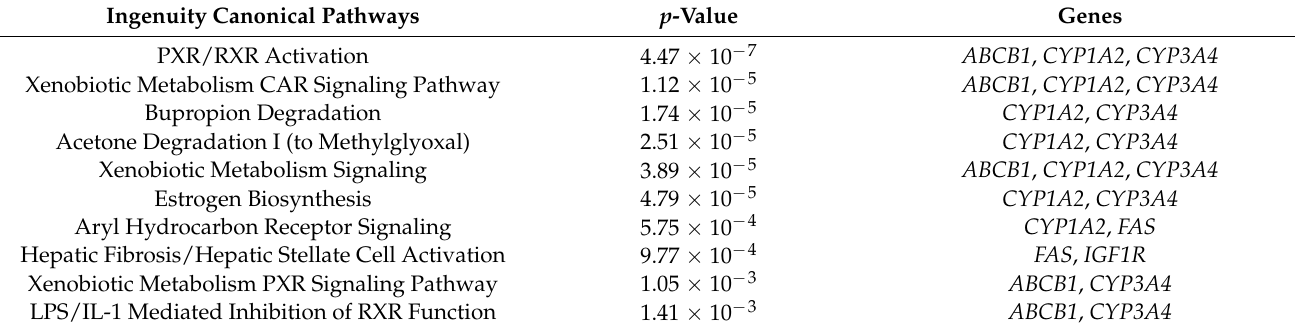
Table 1. Ingenuity Pathway Analysis showing overrepresented pathways (Fisher’s Exact Test p < 0.05) of the six genes found in the molecular databases. Pathways with significant p -values > 0.01 are displayed in Appendix D. Ingenuity Canonical